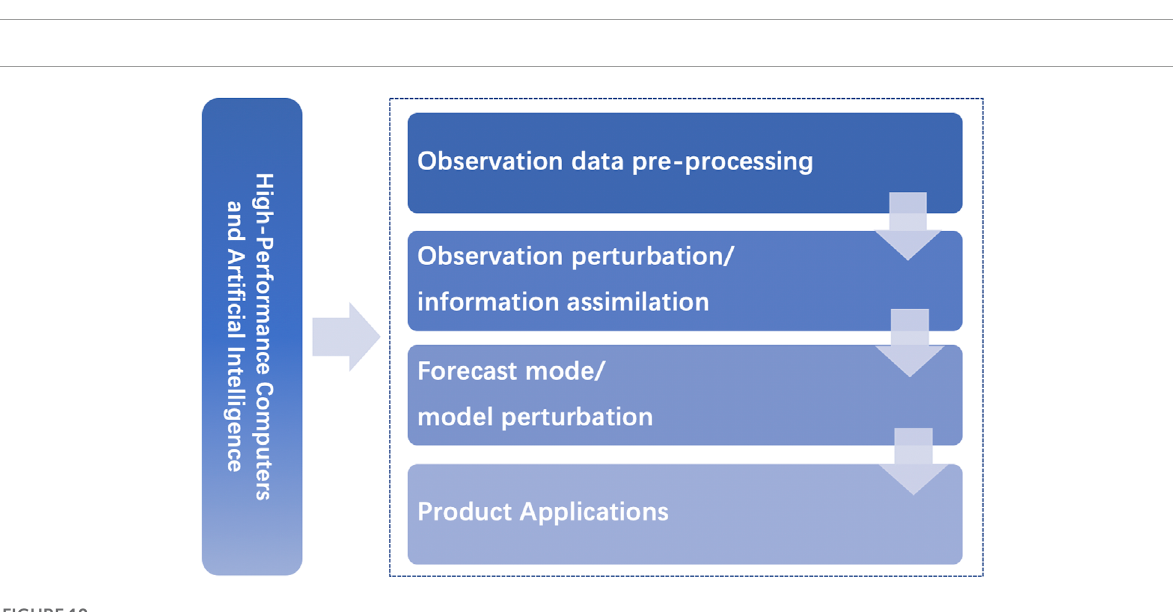
FIGURE 9 This figure is a concrete example of a hybrid model for predicting sea surface temperature. A convolution-deconvolution network can generate a motion field of water. Then, the motion field and the initial input predict the state after a time step by a physical model. Adapted from Figure 1 of De Bézenac et al. (2019).